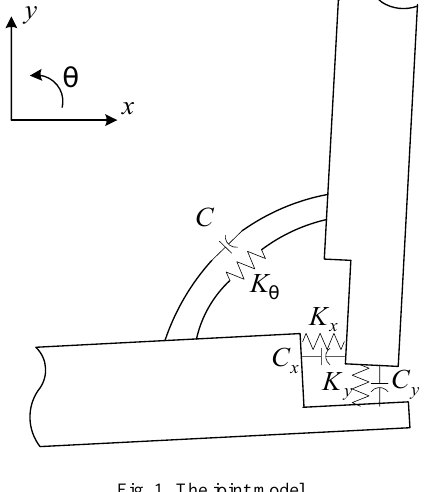
Fig. 1. The joint